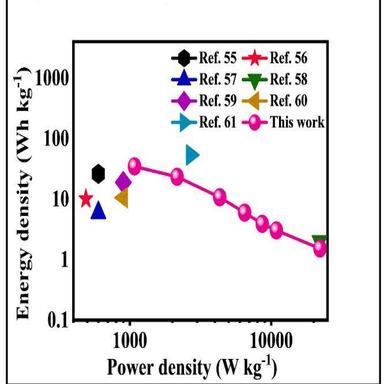
Ragone plot comparing PDI-NDI-PDI/GF//PDI-NDI-PDI/GF with reported SSC device: GH-DN//rGO-NDI, NDI-2DP/CP//NDI-2DP/CP, NQ-DP/CP//NQ-DP/CP, P2P(NDI2ODOTh(NPV)//P2P(NDI2ODOTh (NPV), NDI-Trp-DP/GF//NDI-Trp/GF, NDI-Tyr-DP/GF//NDI-Tyr/GF, PDI-Pyr/GF// PDI-Pyr/GF.